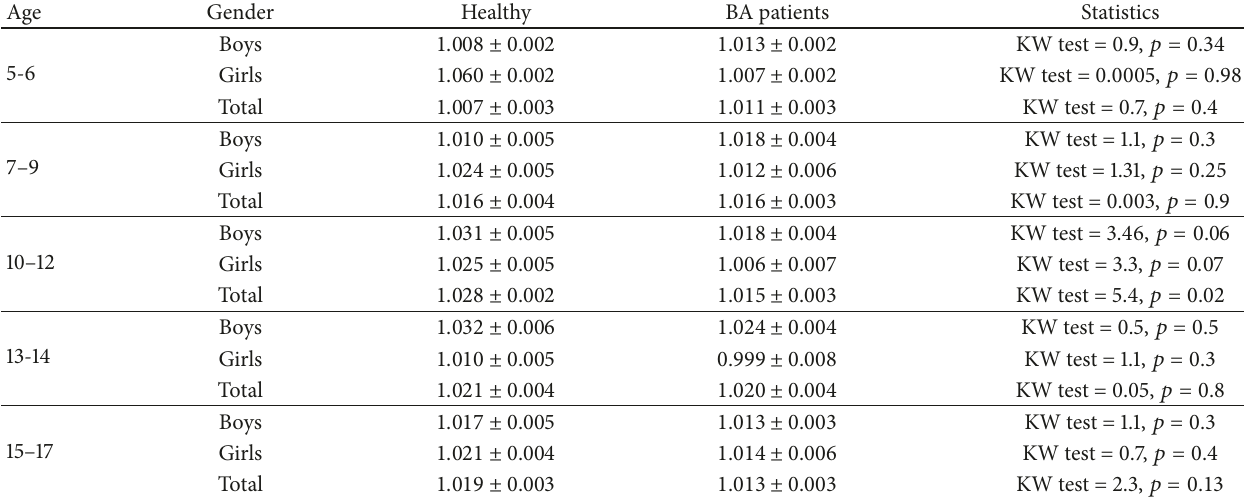
Table 5: Relative index (RI) of body height in the BA patients of different age and sex in comparison with healthy children. Age Gender Healthy BA patients